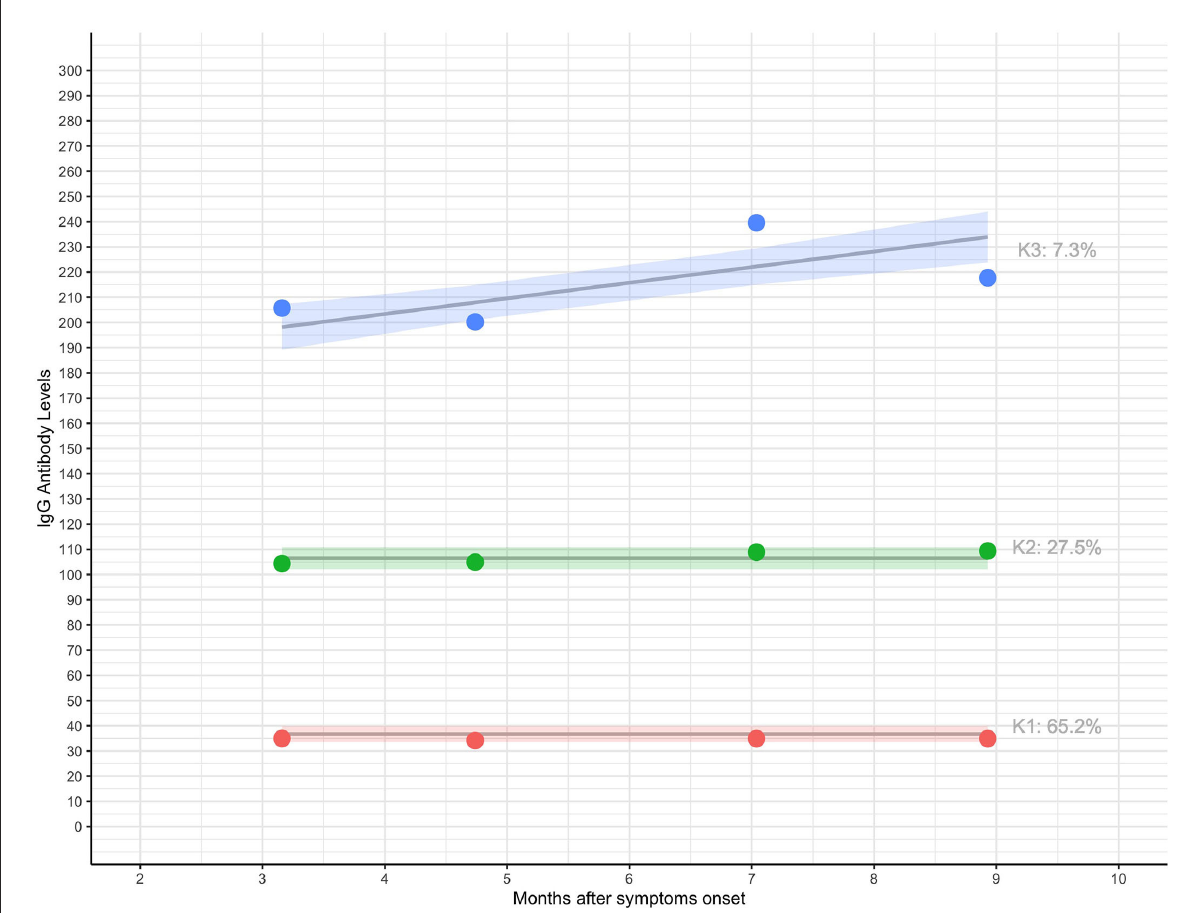
FIGURE3 Antibody kinetics, and proportion of individuals in the groups. Shapes represent observed membership and lines represent predicted group memberships.